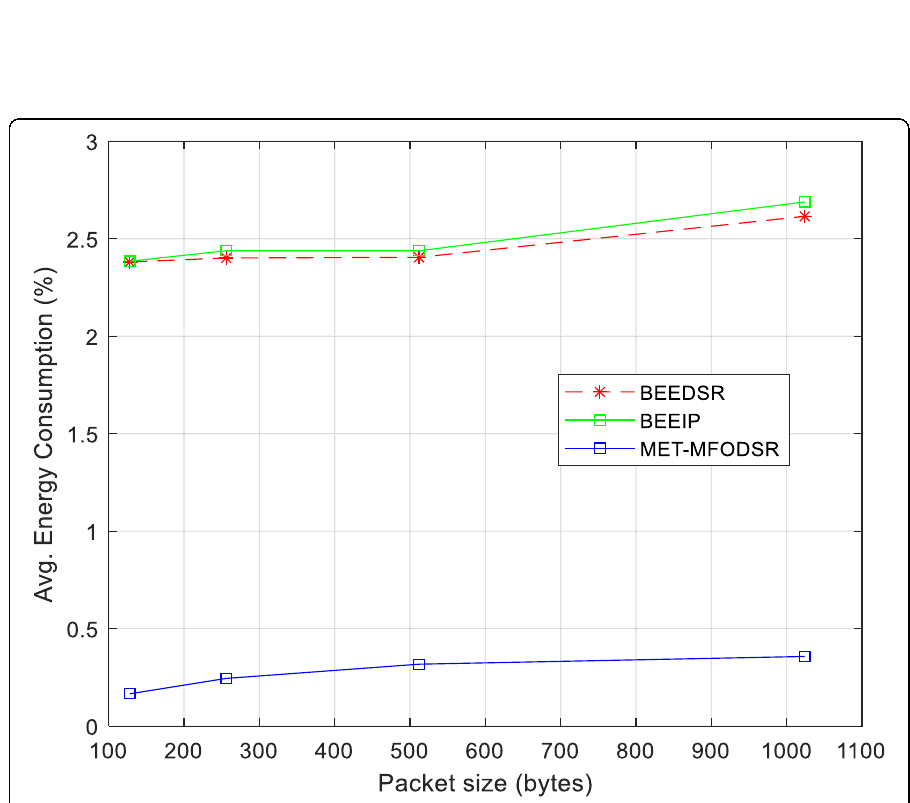
Fig. 8 Average energy consumption for BEEDSR, BeeIP, and MET-MFODSR. The simulation results of the average energy consumption under the packet size